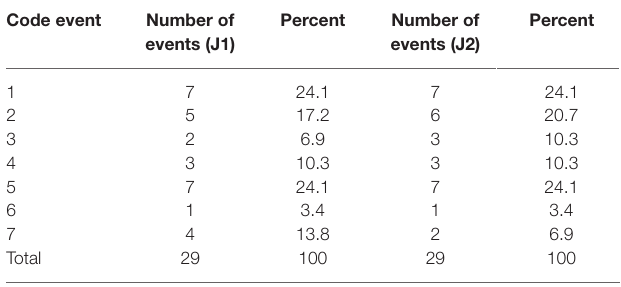
TABLE 3 | Code events E29 (J1 and J2).